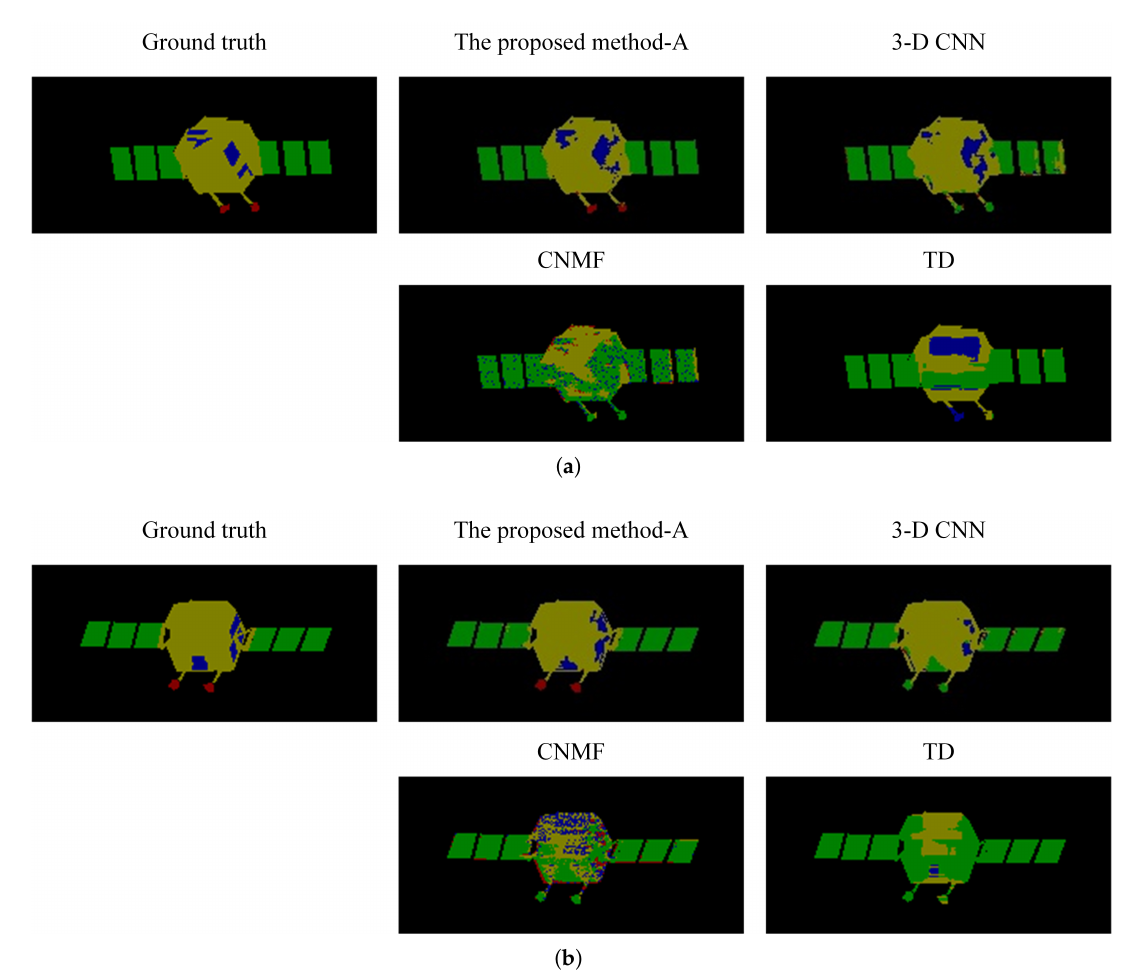
Figure 17. Examplesofmaterialidentificationresultsusingthemeasureddata( a )example1; ( b )example2. Table 6. F1-measure (%) table of the measured